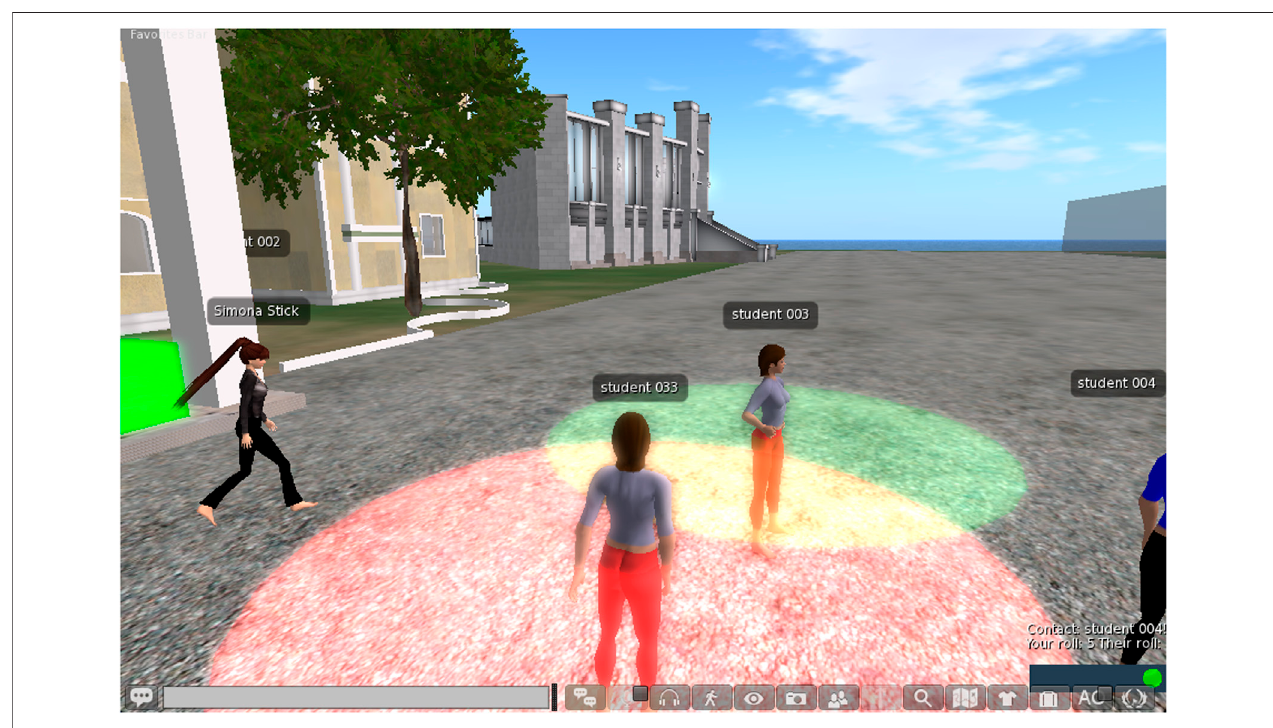
FIGURE 1 | Avatars encroaching in to